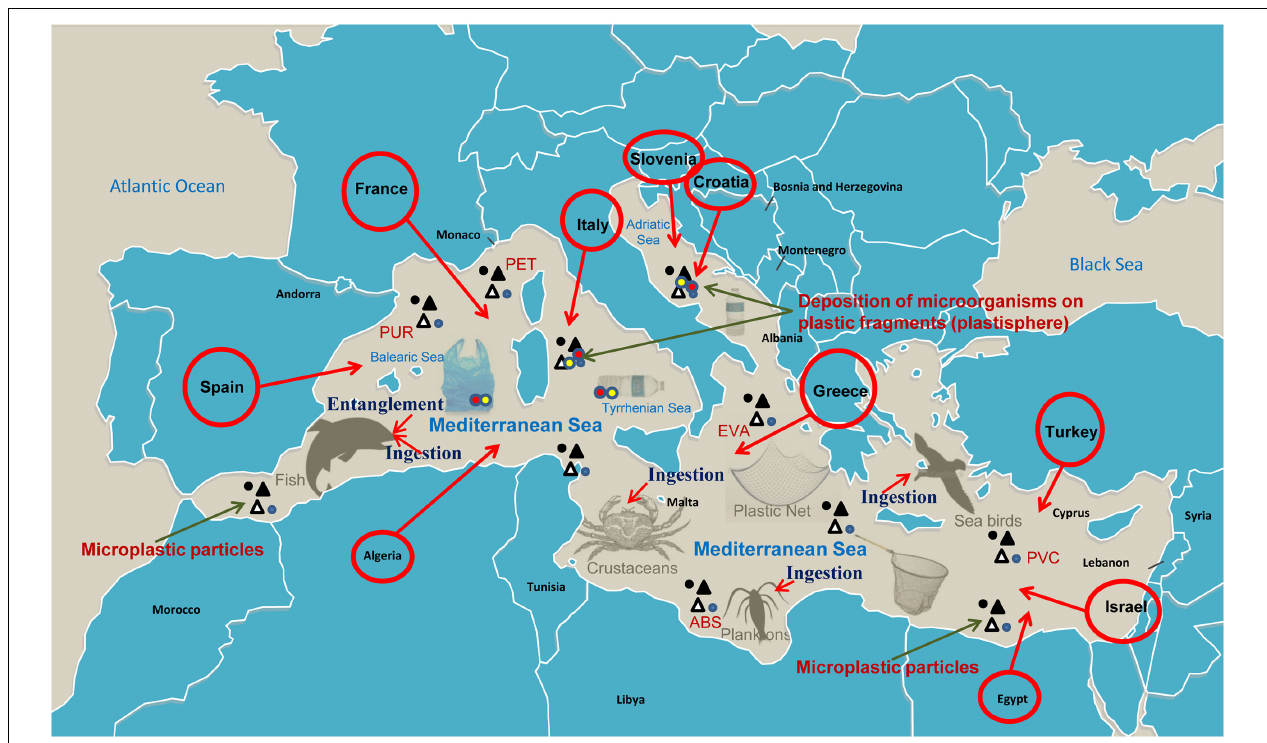
FIGURE 1 | An overall representation of Mediterranean Microplastic pollution. The countries that contribute to the major amount of plastic litter and microplastics in the Mediterranean Sea are marked with red color. Plastic families found on the Mediterranean coast and in the Mediterranean Sea are also mentioned on the map. The plastisphere and the marine animals (inhabiting the Mediterranean Sea) affected due to entanglement and ingestion are shown separately (Map source: